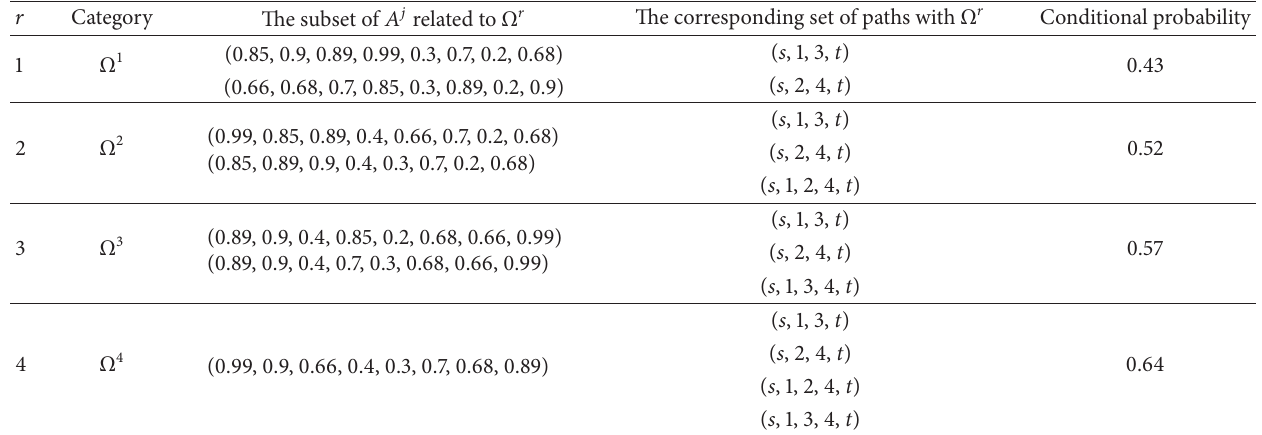
Table 1: Final result of